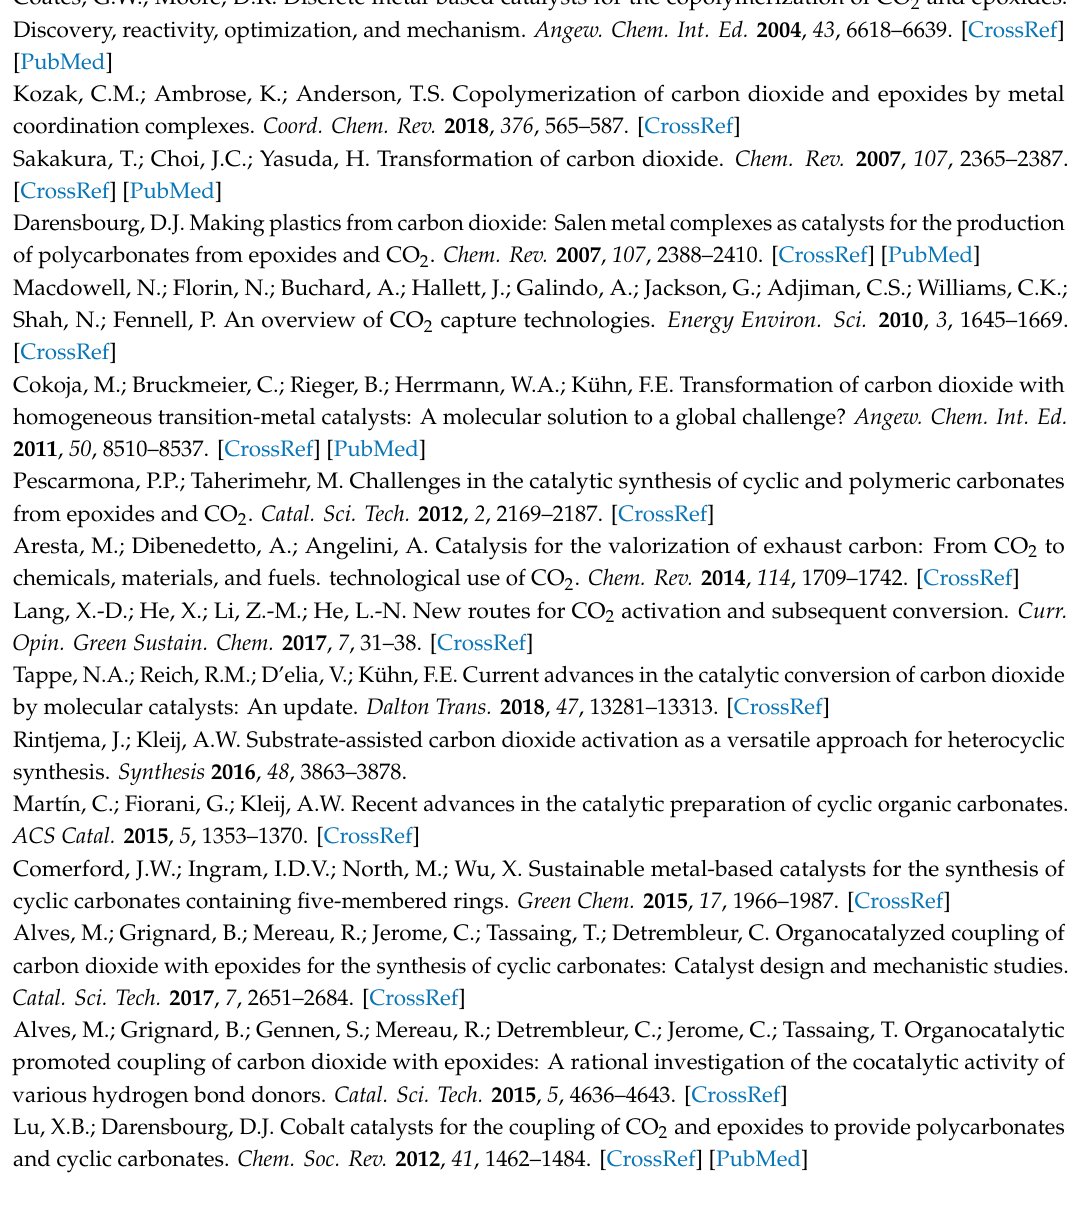
ESI 3-Table S1: Sc and Y complexes investigation, ESI 4-Table S2: Solvent e ff